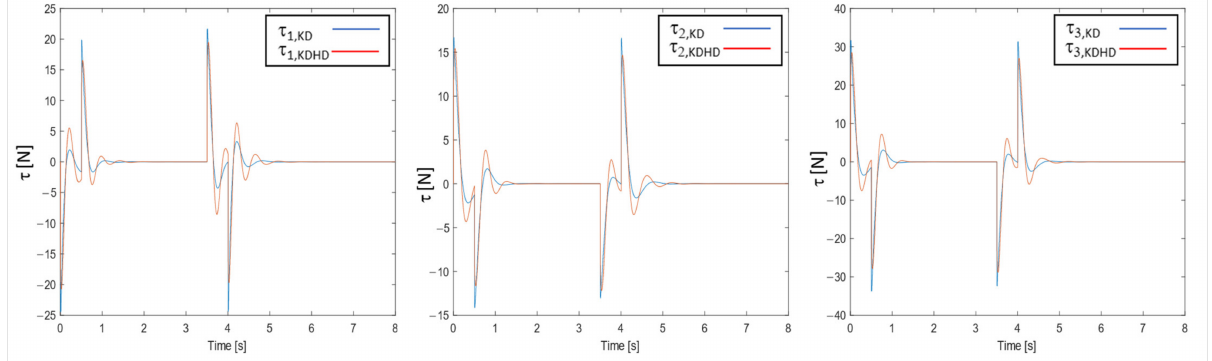
Figure 4. Case study A, k KD = k KDHD = 1 · 10 3 N/m, KD-KDHD comparison number I, ramp time t ramp = 0.5 s, stop time t stop = 3 s, external coordinates.